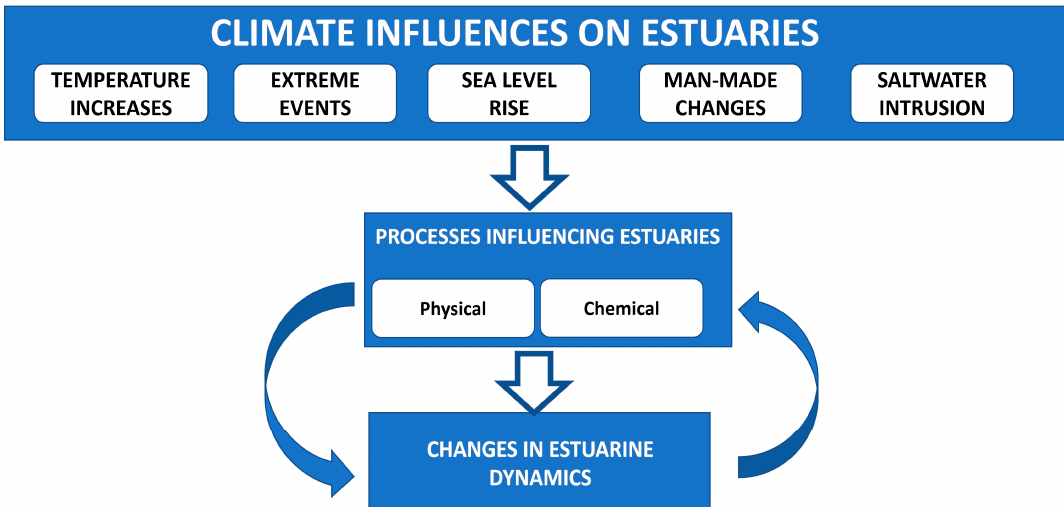
Figure 2. The climate influences and the change in estuarine dynamics and habitat of the three estuaries: the RdlP, Argentina-Uruguay; Mondego, Portugal; and Meghna, Bangladesh.